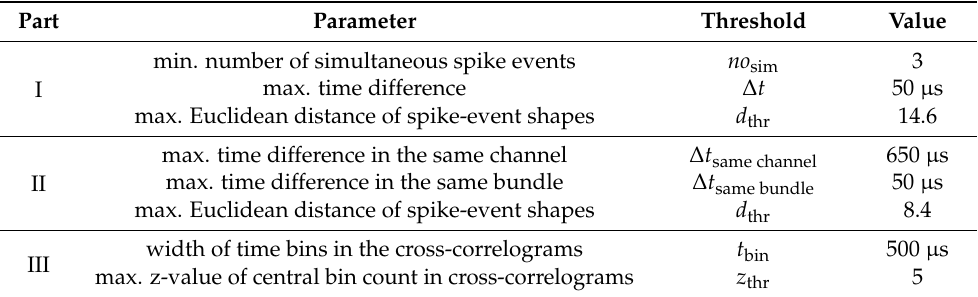
Table 4. Default parameters of the DER